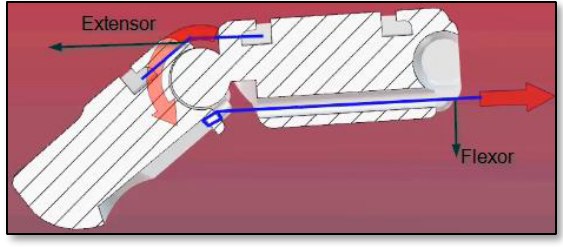
Figure 2. Joint motion